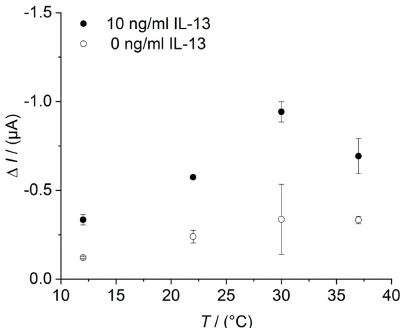
Figure A5. Determination of temperature optimum of the IL-13 immunosensor in the flow cell. Amperometric measurements performed at 0.0 V. Sensor with 10 ng/mL of IL-13 (black circles) and sensor with 0.0 ng/mL of IL-13 (white circles), each measured two times in series at the same temperature. Temperature of 12 ◦ C, 22 ◦ C, 30 ◦ C, and 37 ◦ C applied. Measurements in flow cell with continuous flow of 1 mM hydroquinone in 0.1 M PBS pH 6 with 0.8 mL/min, injection flow of 1.5 mM hydrogen peroxide in 0.1 M PBS pH 6 with 0.4 mL/min, and injection volume of 100 µ